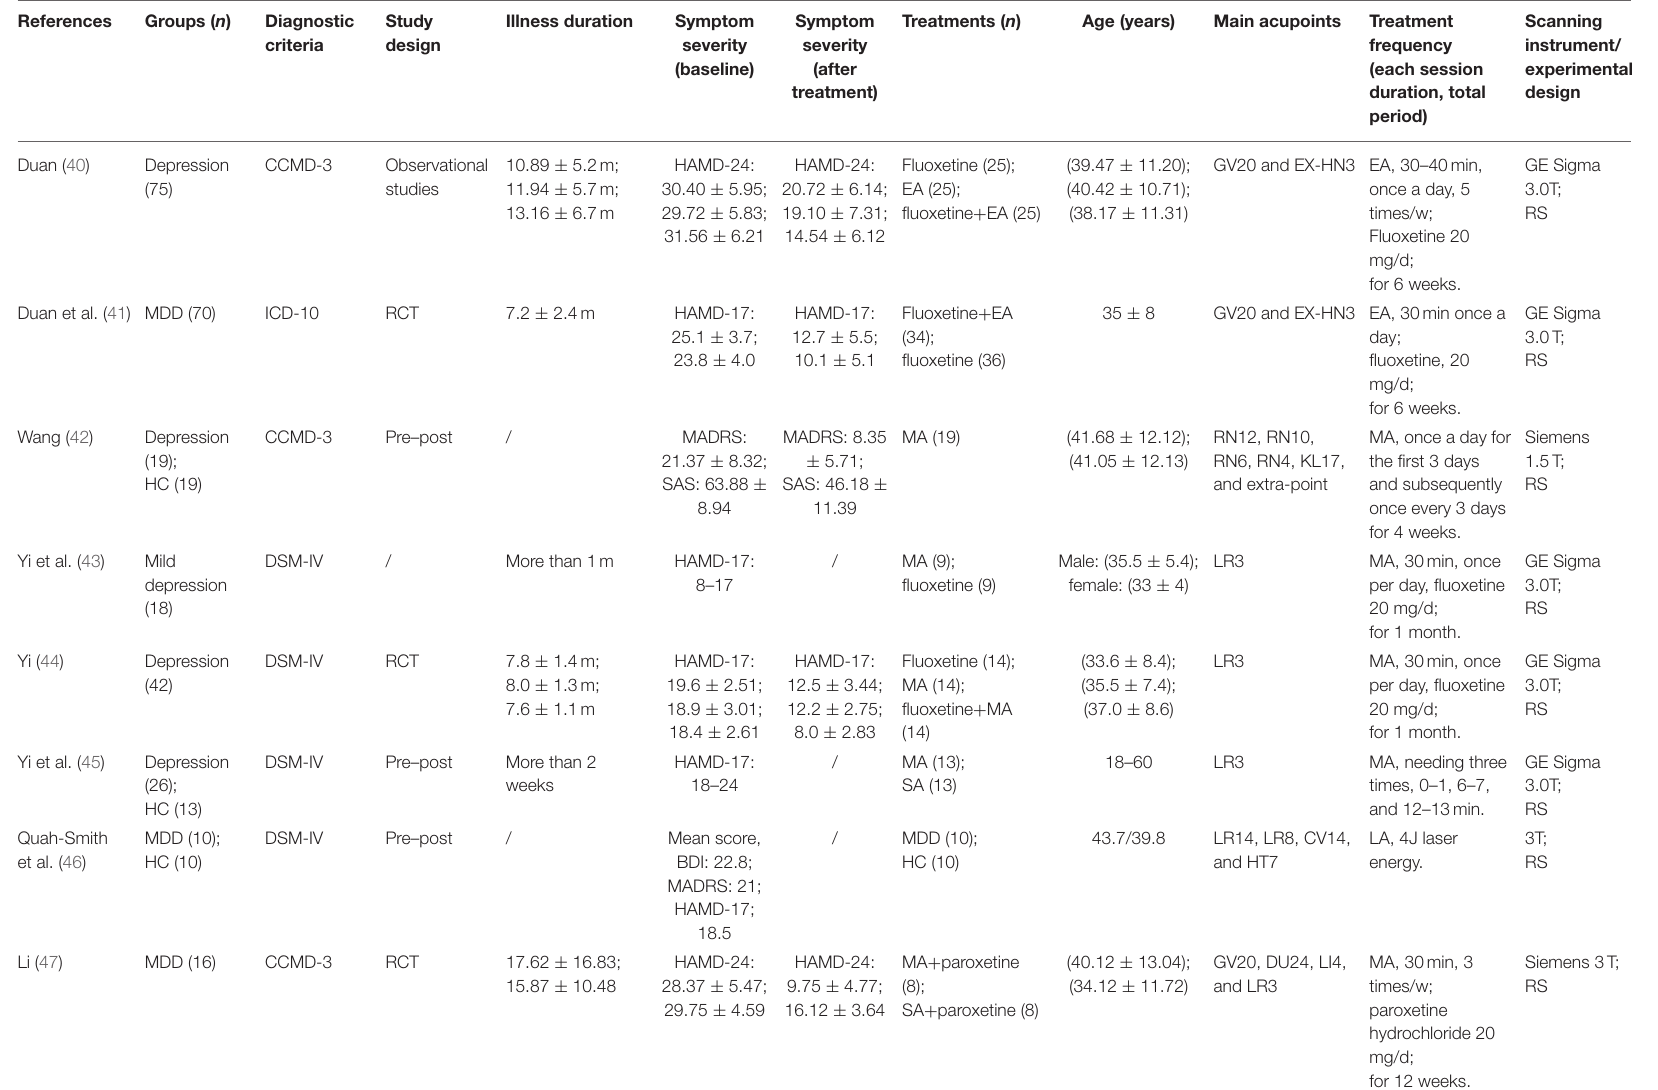
TABLE 1 | Demographic and clinical characteristics of included